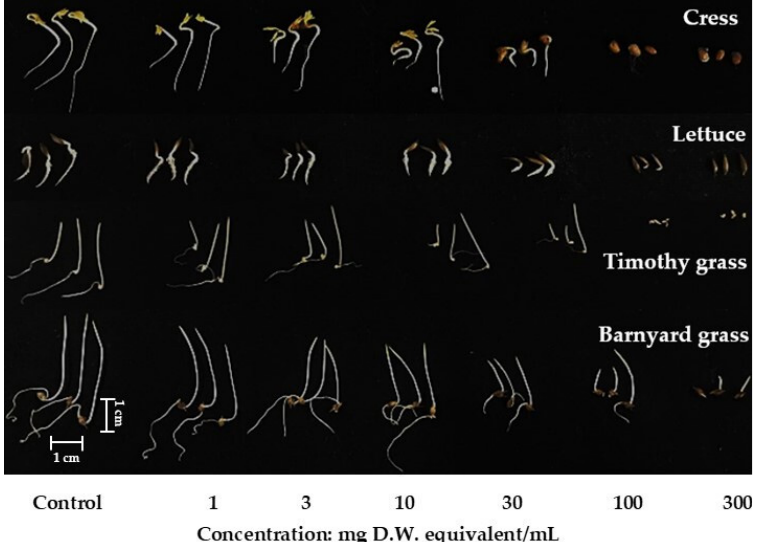
Figure 2. Effect of Polygonum chinense plant extracts on the hypocotyls/coleoptiles and root length of four test plant species at different extract concentrations after 48 h of treatment. (D.W.: dry weight).